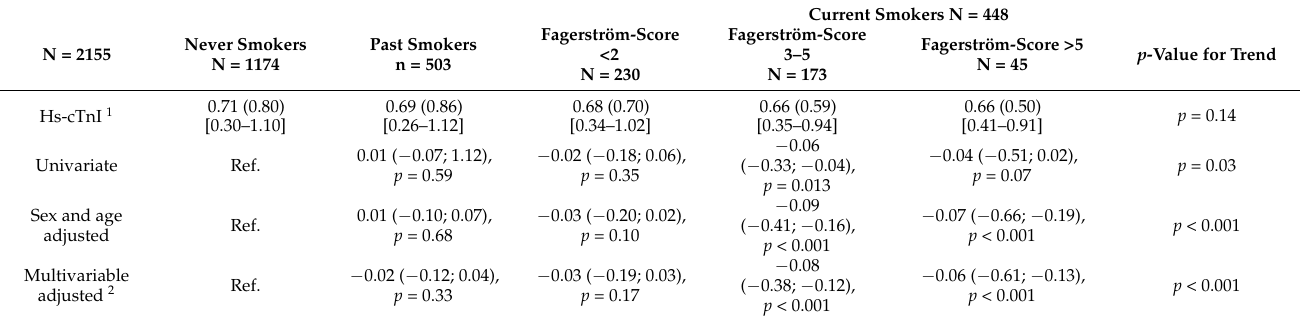
Table 4. Results of the relationship between Fagerström scores and hs-cTnI.